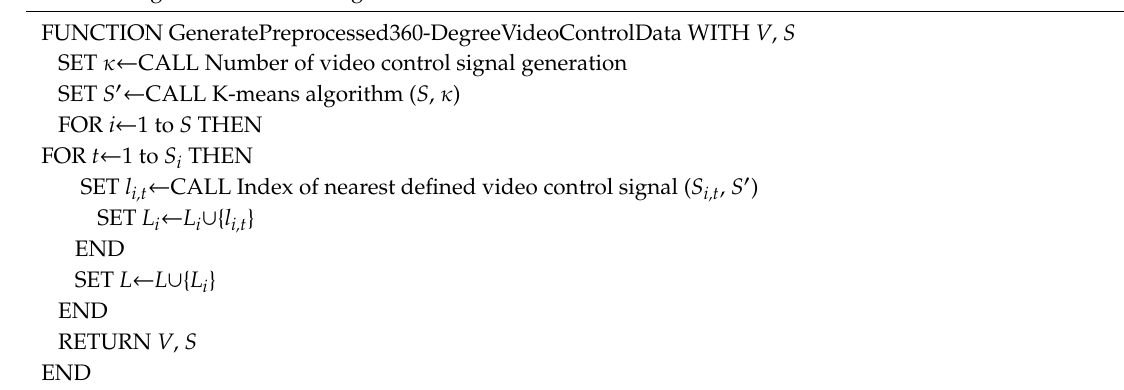
Algorithm 1 Pseudocode for generating preprocessed 360-degree video control data using 360-degree video and 360-degree video control signals.